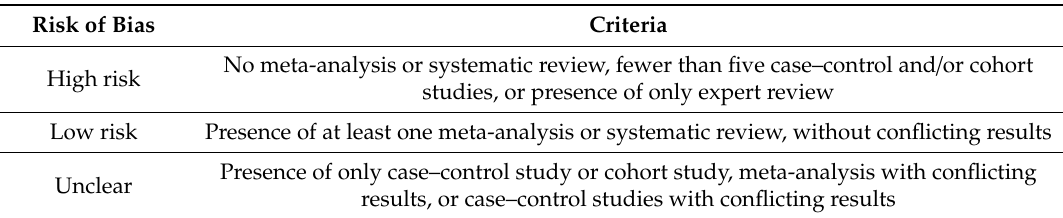
Table A3. Neurotoxic and modulatory KYN levels were assessed according to the criteria of availability of meta-analysis or systematic review, study types, and with or without conflicting results, in order to judge evidence levels of high risk, low risk, or